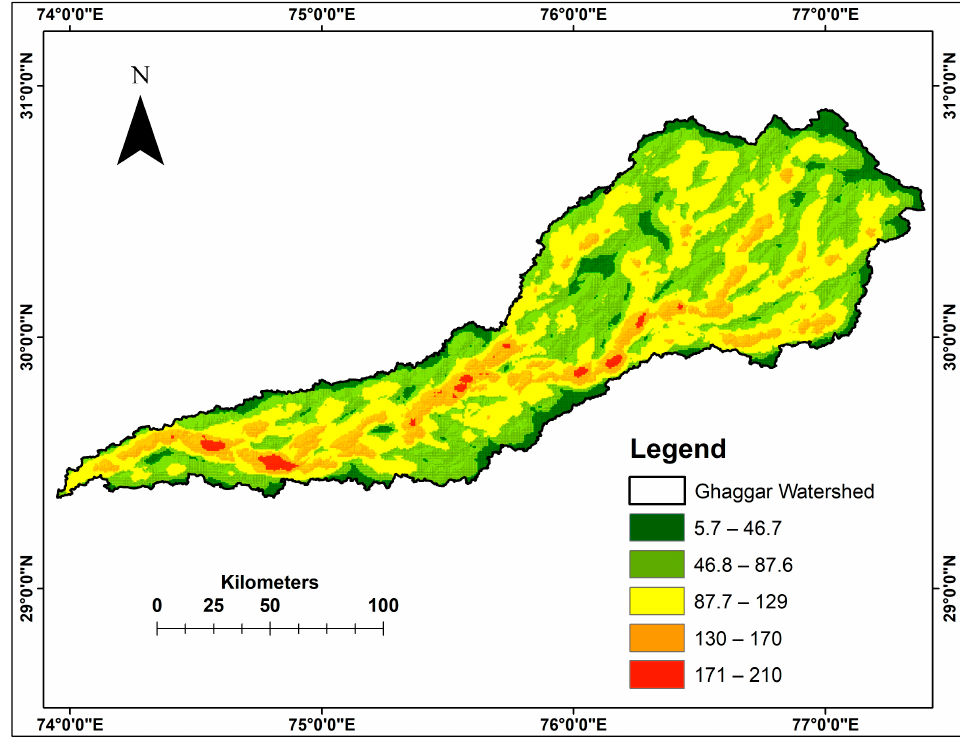
Figure 8. Drainage density of study region (no. of stream in per sq. km).